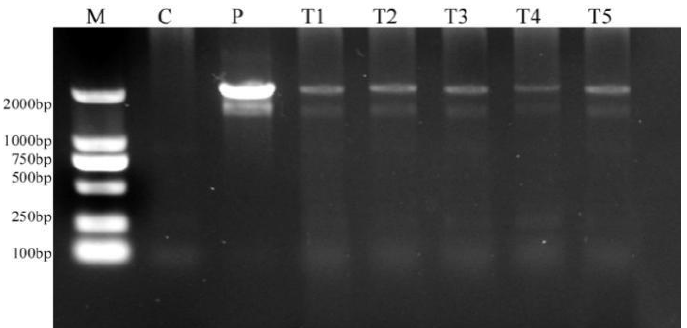
Figure 6. PCR amplification of transgene (GUS) in the resistant secondary somatic embryos obtained from the explants after being cultured for 40 days in the selection medium. M: DNA marker; C: negative control; P: positive control, plasmid DNA; T1–T5: kanamycin-resistant embryos.